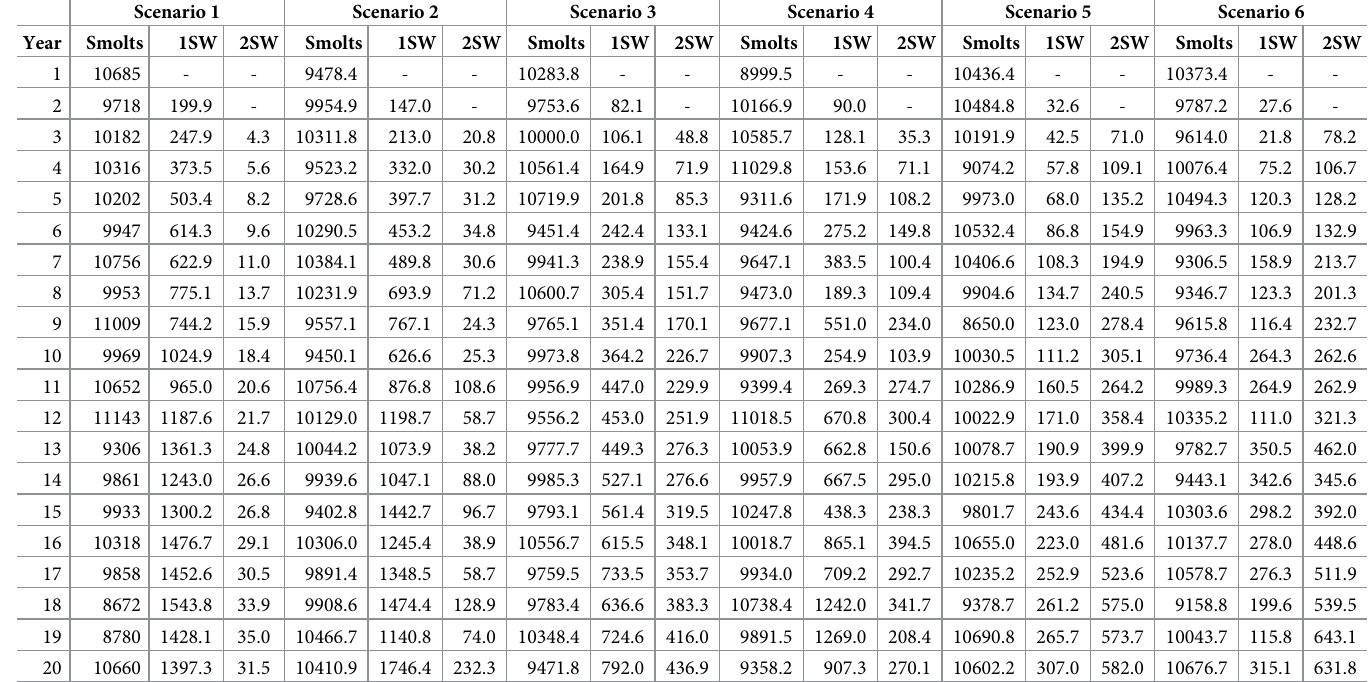
Table 2. Simulated abundance time series of smolts, one-sea-winter (1SW), and two-sea-winter (2SW) returns for all six scenarios